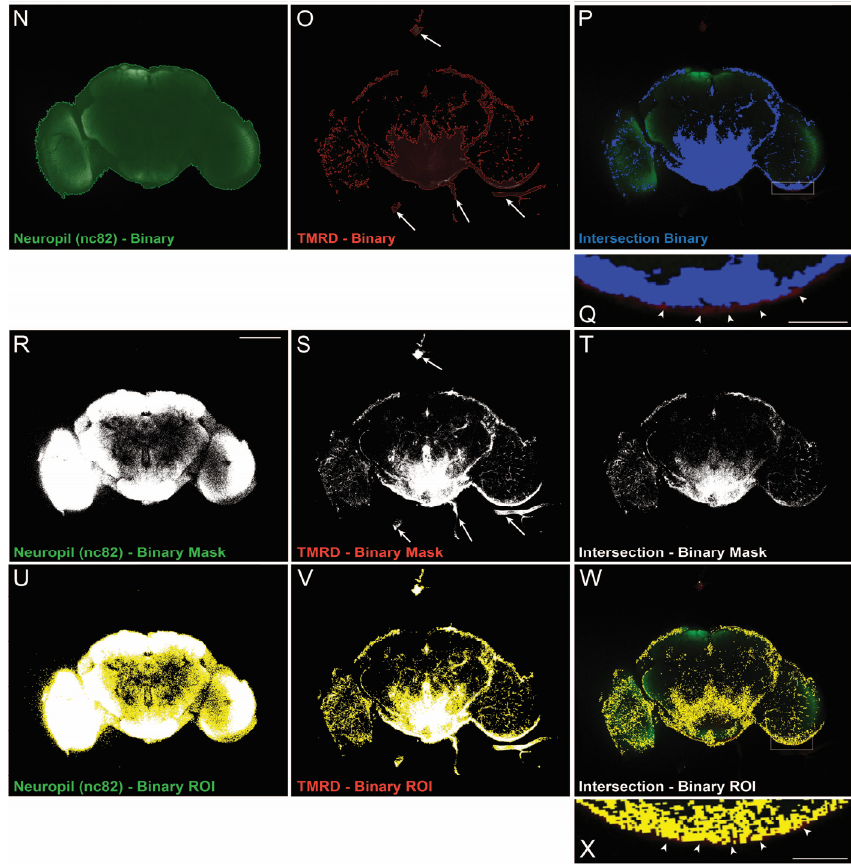
Figure 1. Different methods of assessing dye infiltration into the adult Drosophila brain. ( A – G ) Repre- sentative maximum projection laser-scanning confocal images of a d10 w 1118 female whole-mount brain injected with 10 kDa tetramethylrhodamine dextran (TMRD) on d9 showing: ( A ) DAPI, ( B ) TMRD, and ( C ) merged channels. White arrows point to structures outside the brain that have taken up TMRD, and white arrowheads point to TMRD at the glial barrier. ( D – G ) NIS Elements software autodetection of ( D ) an overestimated ROI (shaded region), ( E ) an underestimated ROI (shaded region), and ( F ) manual correction of ROI to exclude structures outside the brain (arrows in ( C )). Inset in ( G ) shows TMRD at the glial barrier (arrowheads) that is arbitrarily included in the ROI. ( H – J ) Representative maximum projection laser-scanning confocal images of a d10 w 1118 female whole-mount brain injected with TMRD on d9 showing: ( H ) Neuropil (nc82) staining, ( I ) TMRD, and ( J ) merged channels. ( K , L ) Single z-plane from the same brain in ( H – J ) showing: ( K ) Neuropil (nc82) staining, ( L ) TMRD, and ( M ) merged channels. Arrowheads in ( L ) point to TMRD at the glial barrier. ( N – Q ) NIS Elements binary analysis of a single z-slice image showing: ( N ) Neuropil (nc82) binary alone, ( O ) TMRD binary alone, and ( P ) nc82/TMRD intersection binary. Arrows in ( O ) show TMRD staining outside the brain that is included in the binary ( O ), but excluded from the intersection binary ( P ). Inset in ( Q ) shows TMRD at the blood–brain barrier (arrowheads) that is not included in the intersection binary. ( R – T ) FIJI binary analysis of the same z-slice in ( H – J ) showing: ( R ) Neuropil (nc82) binary mask alone, ( S ) TMRD binary mask alone, and ( T ) nc82/TMRD intersection binary. Arrows in ( S ) show TMRD staining outside the brain that is included in the binary mask ( S ), but excluded from the intersection binary mask ( T ). ( U – X ) FIJI autodetection of ROIs on ( U ) Neuropil (nc82) staining, ( V ) TMRD, and ( W ) nc82/TMRD intersection binary masks. Inset in ( X ) shows the intersection ROI overlaid over fluorescence at the glial barrier (arrowheads). Scale bar in ( A – F ); ( H – P ); ( R – W ) = 100 µ m. Scale bar in insets in ( G , Q , X ) = 20 µ